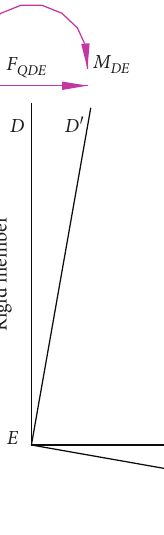
Figure 5: The structural stress of DEF (rigid combination). Due to the shear force and bending moment of the ends in the rigid members, the angular displacement of the ends will occur, but no lateral deflection deformation will